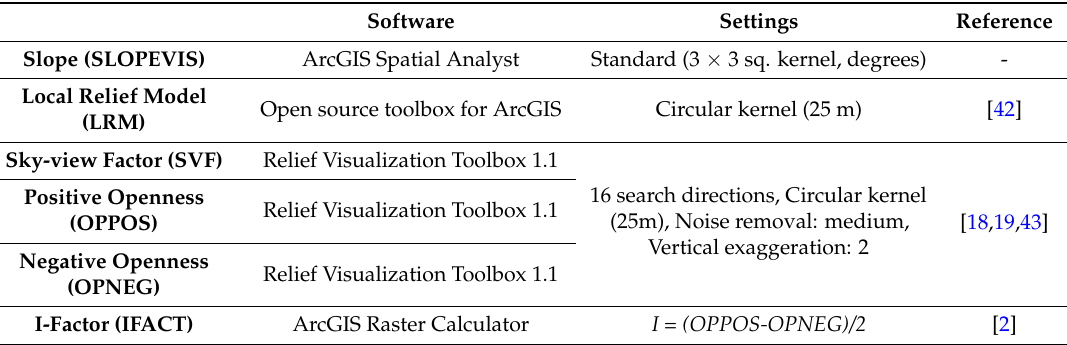
Table 1. Selected visualization techniques, software used, and